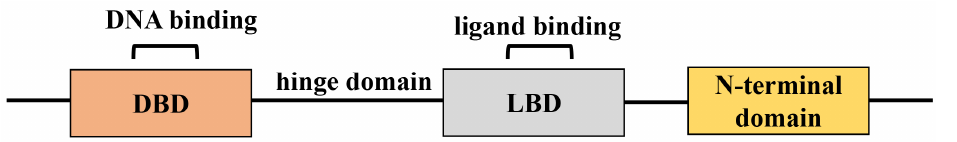
Figure 1. Domain structures of ROR α . There are four main domains including a conserved DNA- binding domain (DBD), ligand-binding domain (LBD), hinge domain, and distinct N-terminal domain.